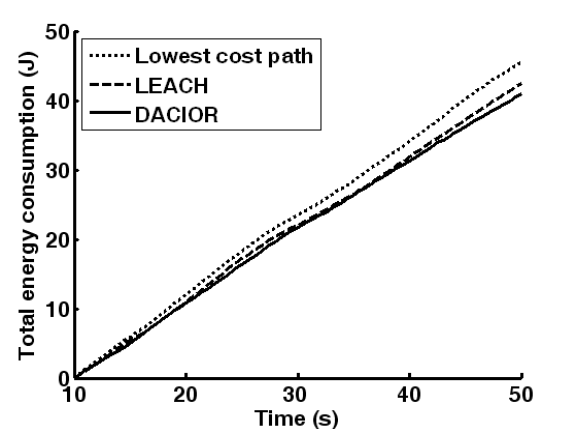
Figure 10. Total energy consumption during target tracking using lowest cost path, LEACH and